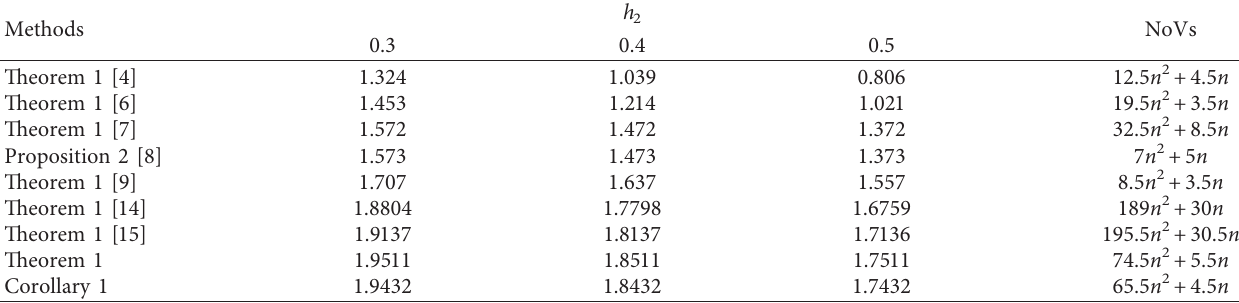
1 ( t ) for different h 2 .